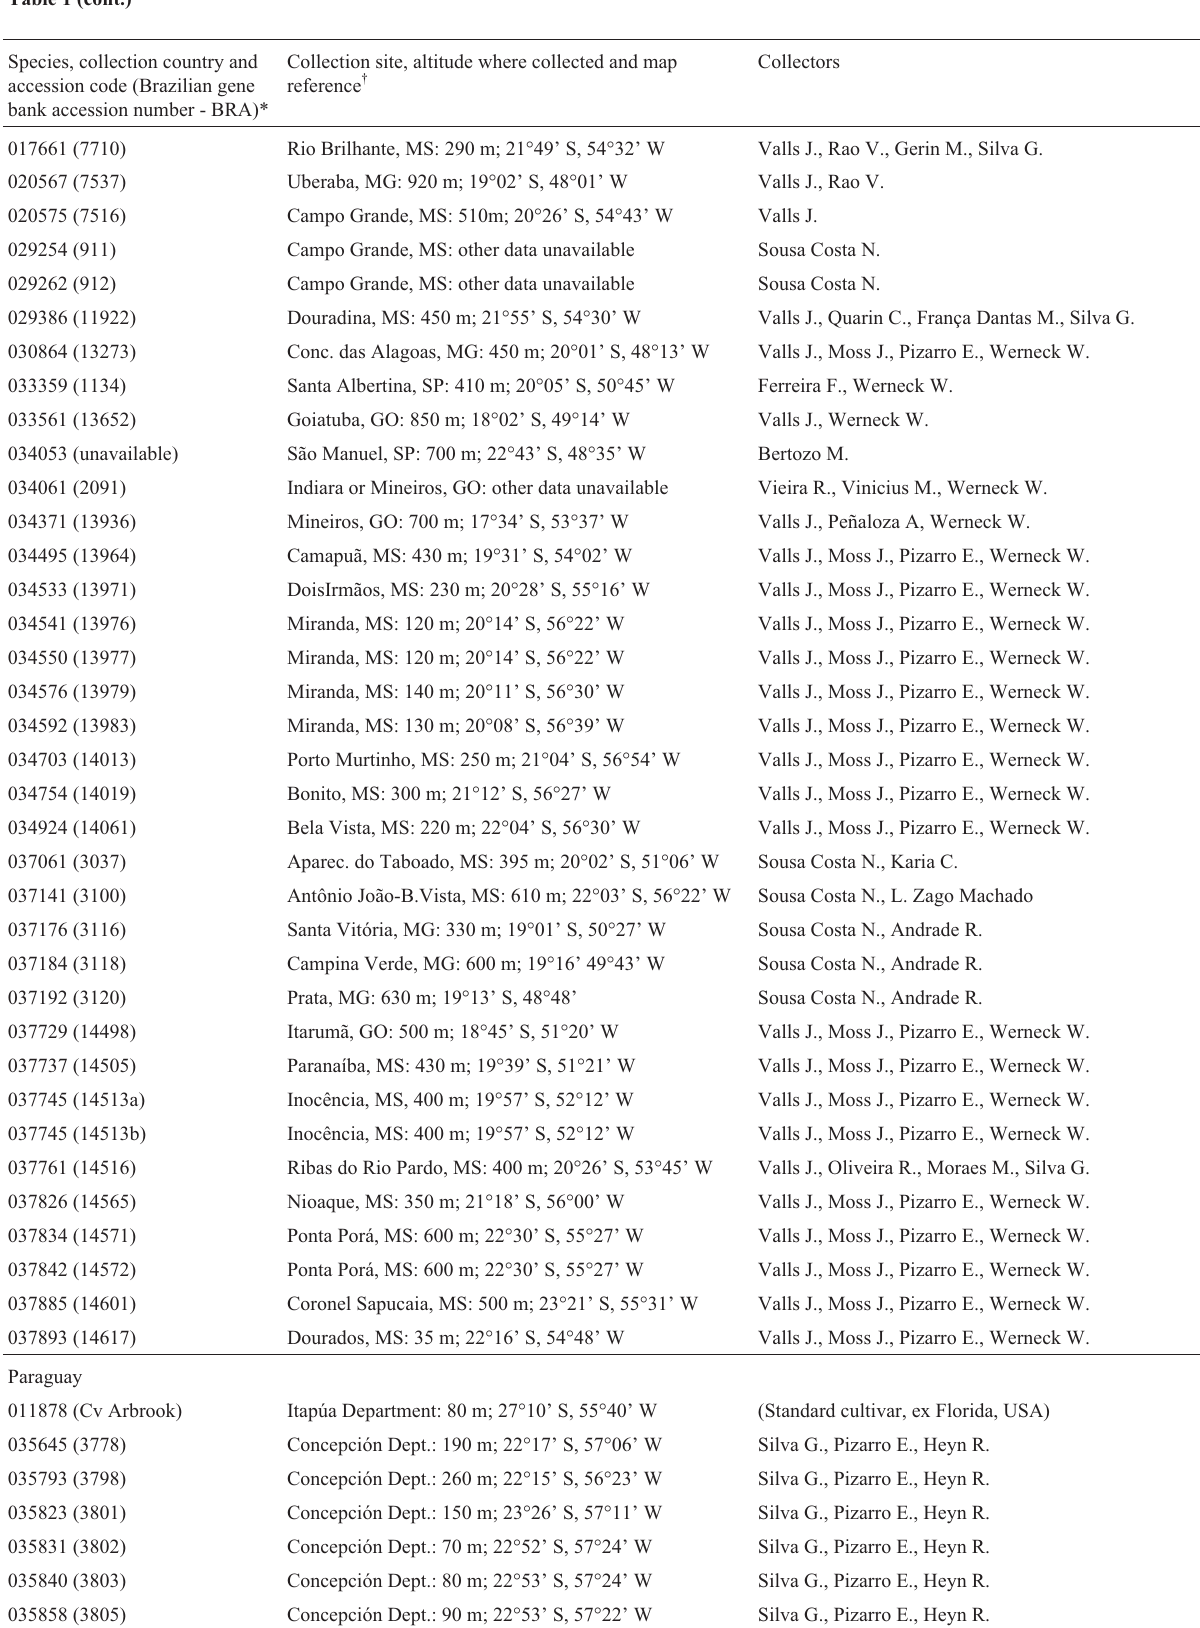
Table 1 (cont.) Species, collection country and accession code (Brazilian gene bank accession number -